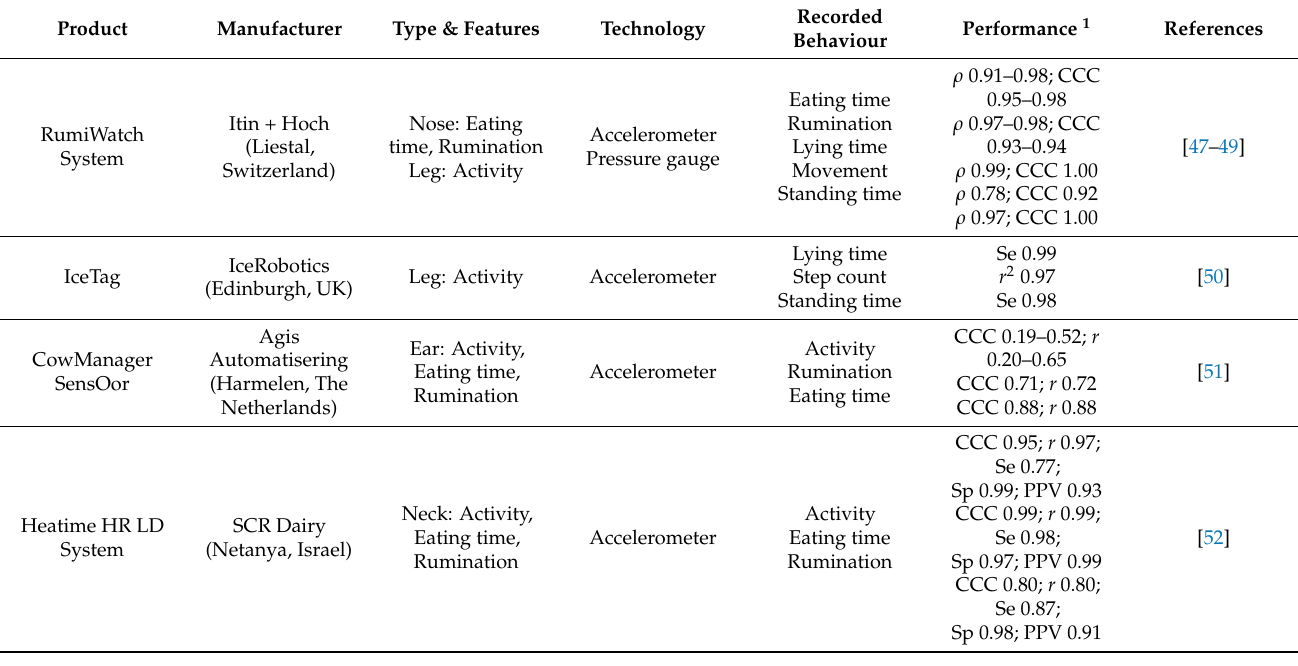
Table 2. Commercially available and scientifically validated animal-based sensors for monitoring ruminant behaviours in pastures. 1 ρ = Spearman’s correlation coefficient, r = Pearson’s correlation coefficient, CCC = concordance correlation coefficient, Se = sensitivity, Sp = specificity, PPV = positive predictive value and r 2 = coefficient of